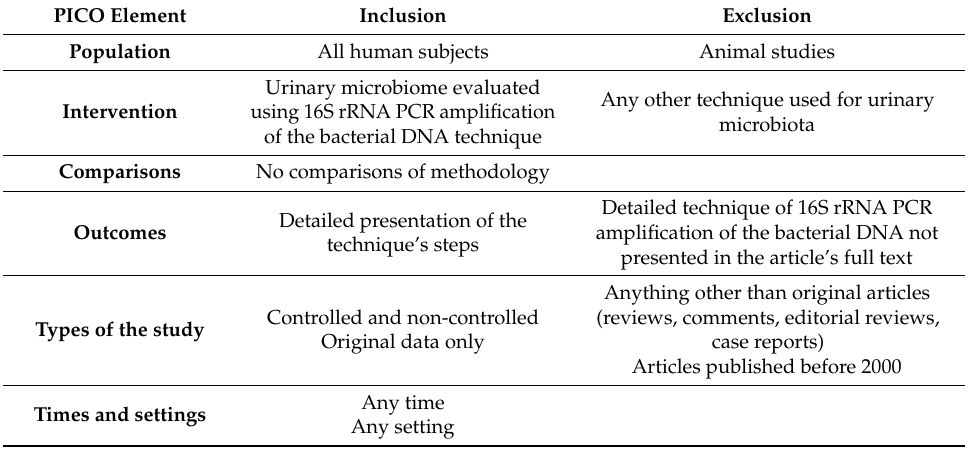
Table 1. The inclusion and exclusion criteria according to PICOS.